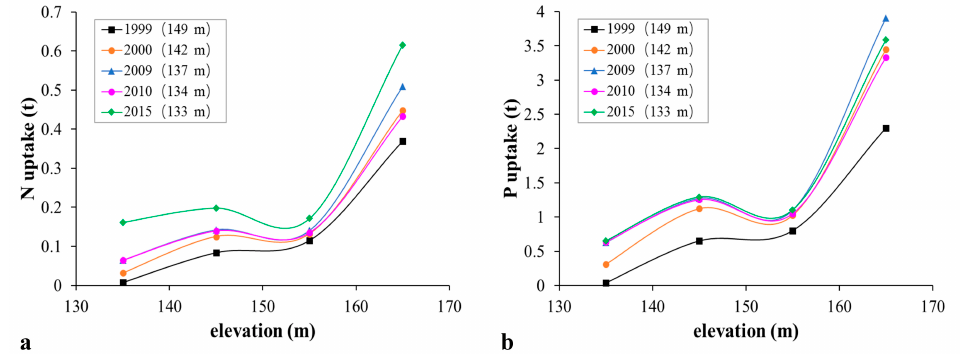
Figure 7. Zonal statistics for N ( a ) and P ( b ) consumed by plants during different years. The water level of each year is shown in parentheses following the year.